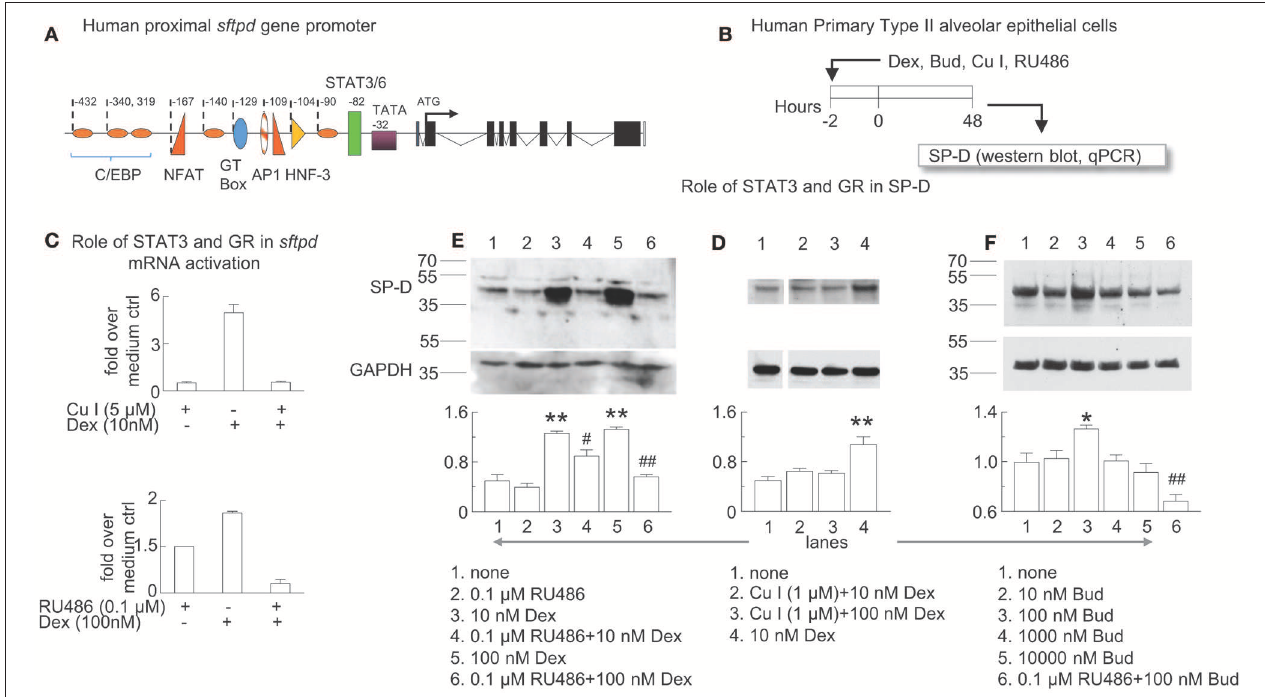
FIGURE 7 | Glucocorticoid receptor-induced sftpd mRNA and protein expression is facilitated by STAT3/6 binding. (A) Schematic of the proximal promoter region of the human SP-D gene ( sftpd ) lacking glucocorticoid response elements. The approximate positions of C/EBP (orange ovals) and STAT3/6 (green rectangle) binding are depicted. Negative values indicate the number of base pairs relative to the start of transcription. (B) Human Primary Type II alveolar epithelial (hAECII) cells were incubated for 2h with dexamethasone (Dex), curcurbitacin I (Cu I), and RU486 as indicated. 48h later, cells were harvested and SP-D was studied by western blot (protein, relative expression to GAPDH) and qPCR ( sfptd mRNA). (C) qPCR of sftpd (fold over no dexamethasone). (D–F) SP-D protein was studied by western blot, compared to control GAPDH. Optical density of SP-D and GAPDH by Image J analysis; GAPDH was subtracted from SP-D density then the ratio over the mean value of “no treatment” group was calculated. Mean ± SEM of n = 6 (C) or n = 3 (D–F) . * p < 0.05, ** p < 0.01 vs. “no treatment”; # p < 0.05, ## p < 0.01 vs. the same concentration of Dex or Bud alone; One-way ANOVA with Bonferroni’s multiple comparison’s test (D–F) . Western blots are representative of three independent